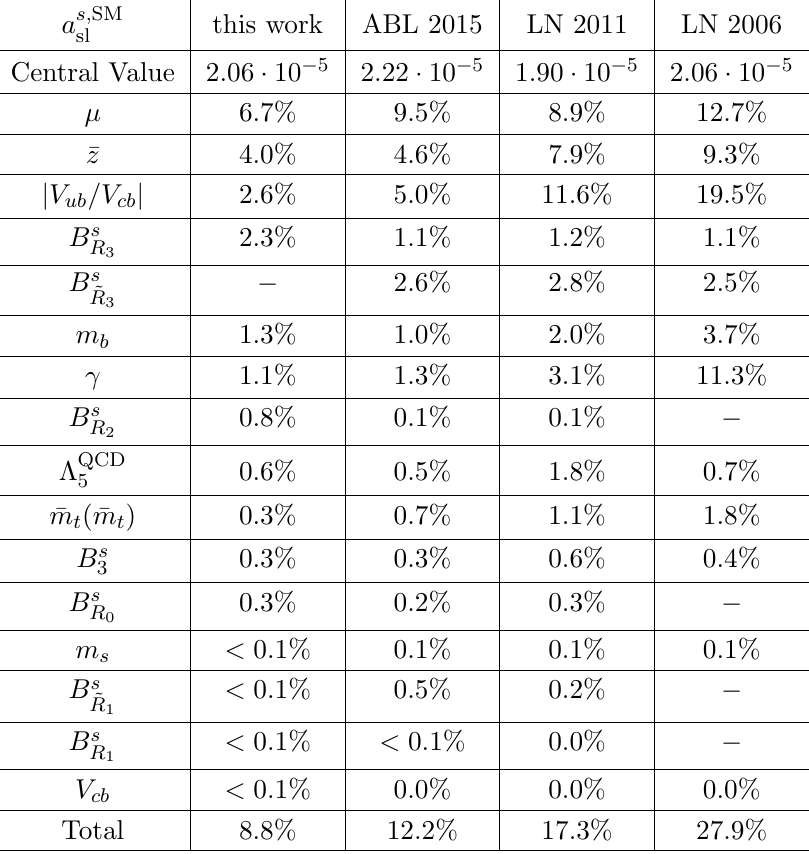
Table 15 . List of the individual contributions to the theoretical error of the semileptonic CP asymmetries a s within the Standard Model and comparison with the values obtained in 2015 [31], sl in 2011 [128] and in 2006 [87]. We have used equations of motion in the current analysis to get rid of the operator ~ R 3